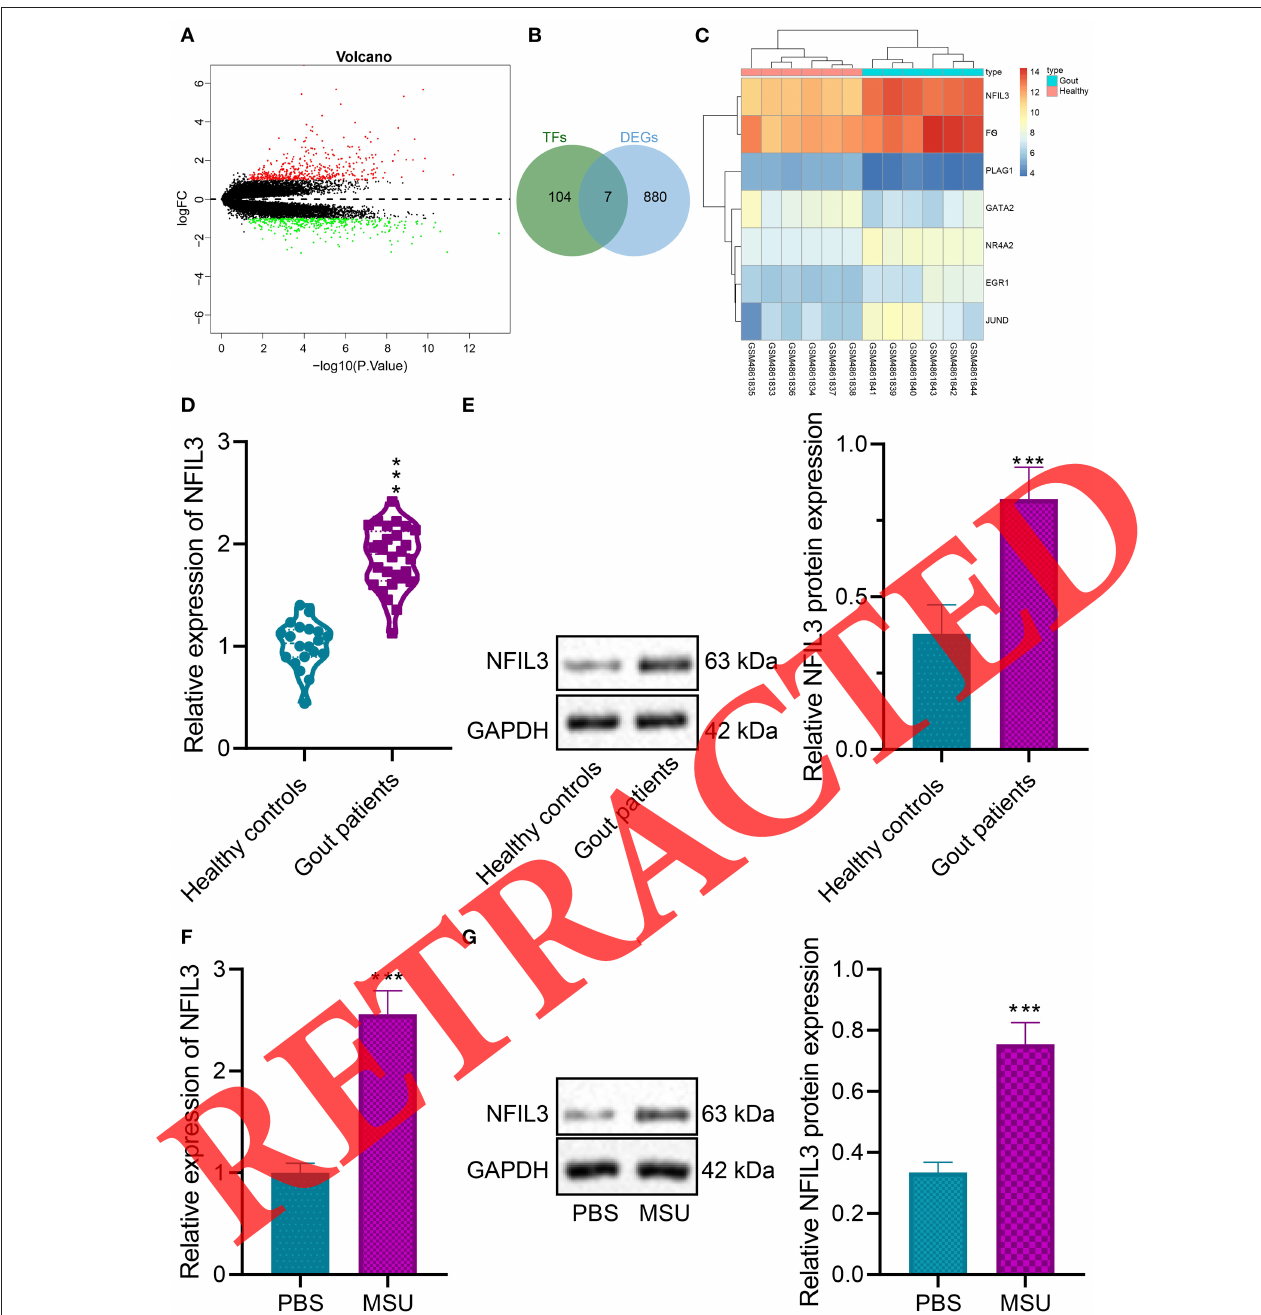
FIGURE 1 | NFIL3 is amplified in the peripheral blood neutrophils of gout patients and MSU-treated neutrophils. (A) A heat plot of differential mRNA expression in the GSE160170 dataset. The abscissa represents the –log10 p -value and ordinate represents the logFC; the red dots indicate highly expressed genes in diseases, and the green dots indicate weakly expressed genes. (B) Venn diagram analysis of differential mRNAs and transcription factors included in the JASPAR. The central represents the intersection of two groups of data. (C) A heat plot of differential transcription factors in the GSE160170 dataset. The abscissa represents the sample number and the ordinate represents the gene name; the upper dendrogram shows the sample clustering and the histogram at the upper left refers to color gradation. (D) mRNA expression of NFIL3 determined by RT-qPCR in the peripheral blood neutrophils of 28 gout patients and 20 healthy controls. *** p < 0.01, compared to healthy controls. (E) Western blot analysis of NFIL3 protein in the peripheral blood neutrophils of 28 gout patients and 20 healthy controls. *** p < 0.001, compared to healthy controls. (F) mRNA expression of NFIL3 determined by RT-qPCR in MSU-treated neutrophils. *** p < 0.001, compared to PBS-treated neutrophils. (G) Western blot analysis of NFIL3 protein in MSU-treated neutrophils. *** p < 0.001, compared to PBS-treated neutrophils. Data are shown as mean ± standard deviation of three technical replicates. Data between two groups were compared using unpaired t -test.